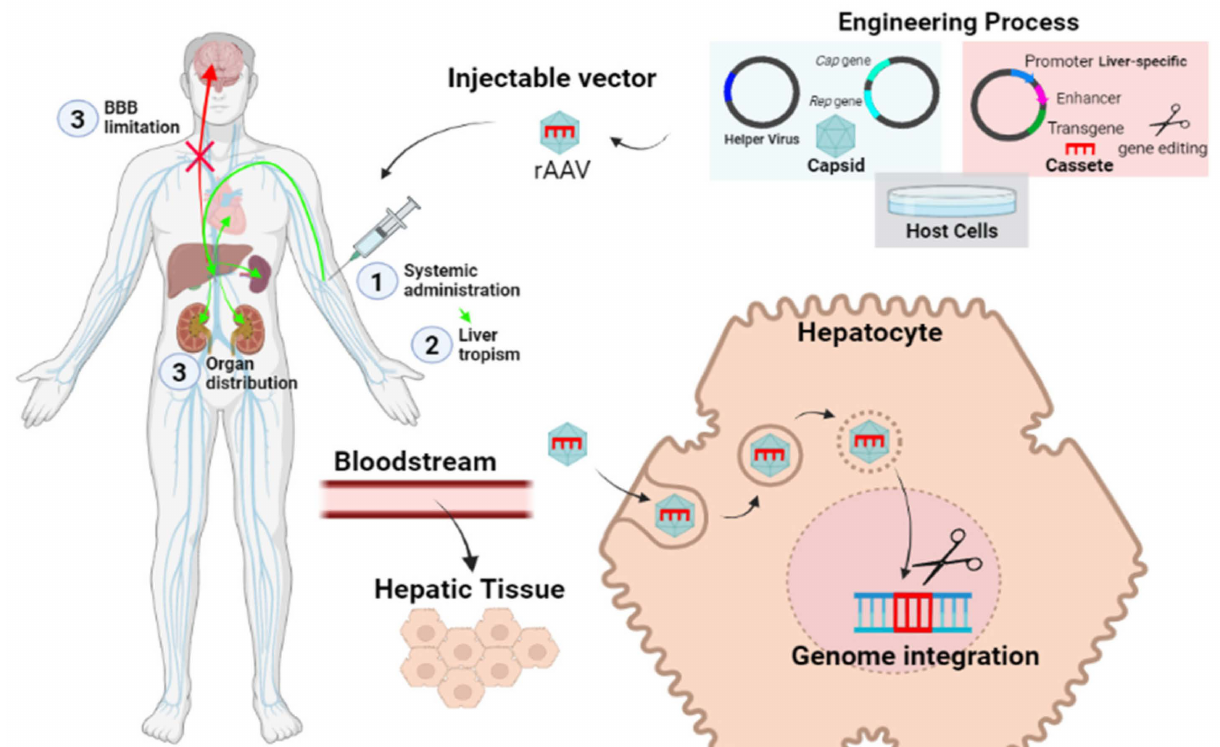
Figure 3. Schematic view of liver targeting in vivo gene